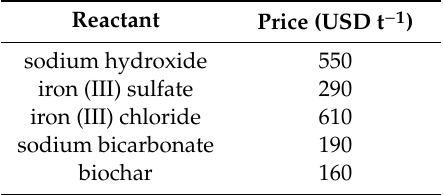
Table 2. Pricing of reactants (converted to theoretical 100% purity) in February